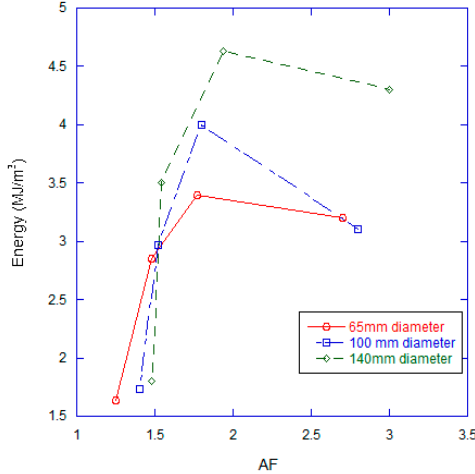
Figure 10. Energy content versus AF for three reactors.